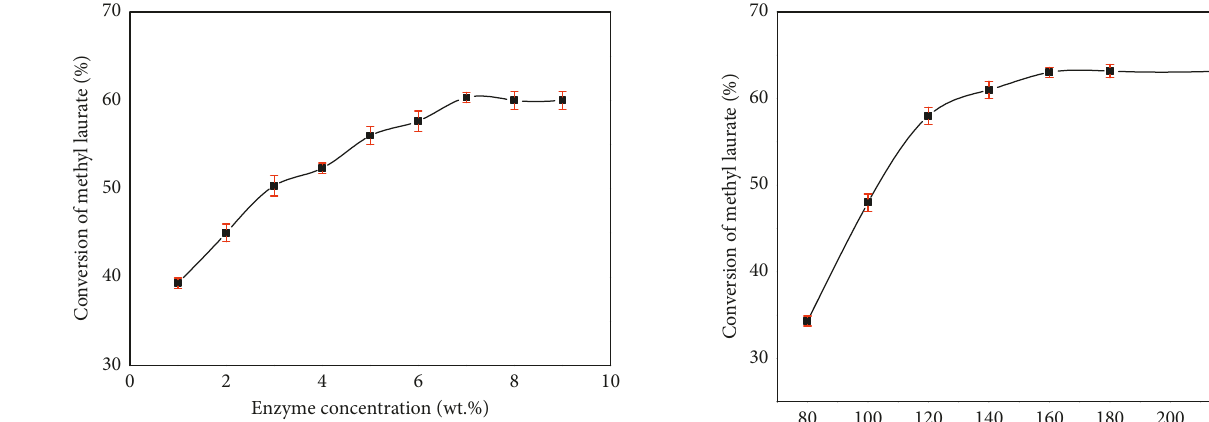
Figure 4: Effect of enzyme concentration on lipase-catalyzed transesterification of decylglycerol with methyl laurate.